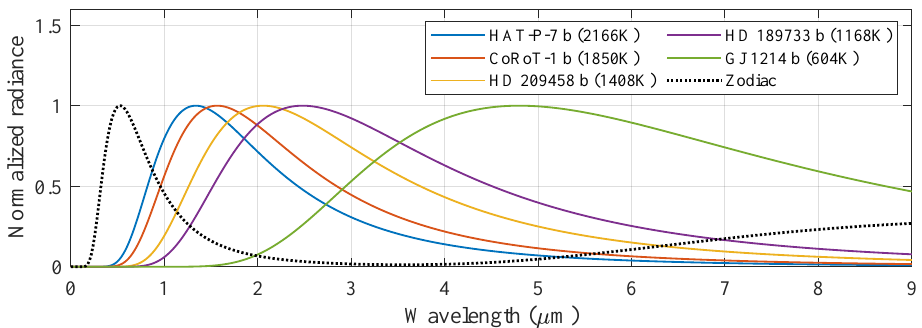
Figure 2. Normalized radiance of several exoplanet candidates and zodiacal